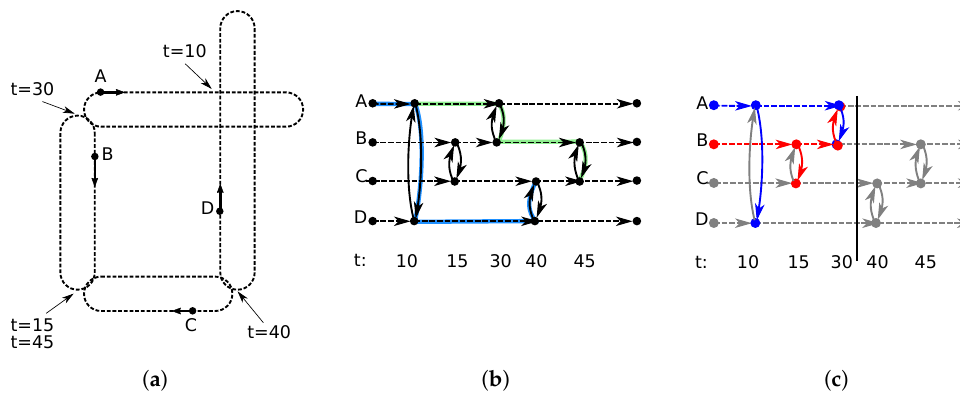
Figure 1. Opportunistic network model construction. ( a ) Mobile devices’ trajectories. The devices move in closed loops, meeting at the indicated times; ( b ) full opportunistic network model built offline using recorded traces (from [8]); ( c ) Online model construction. Learned nodes and edges up to t = 35 for devices A (blue) and B (red) are shown.